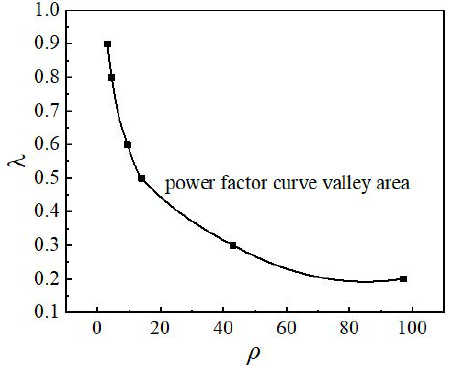
Figure 11. Diagram of power factor curve valley area.